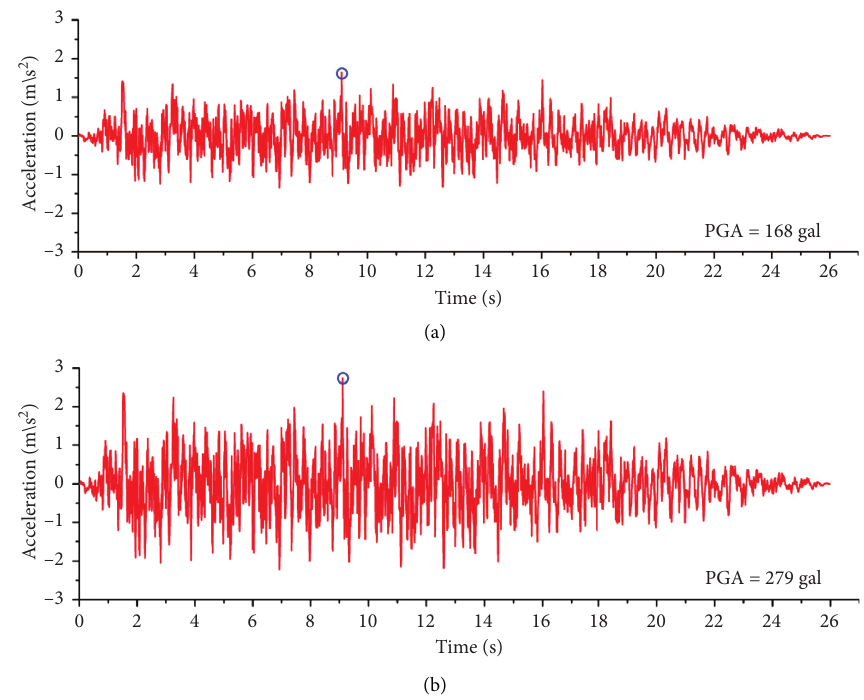
Figure 6: Acceleration-time curve of the seismic wave used in the model. (a) OBE; (b)